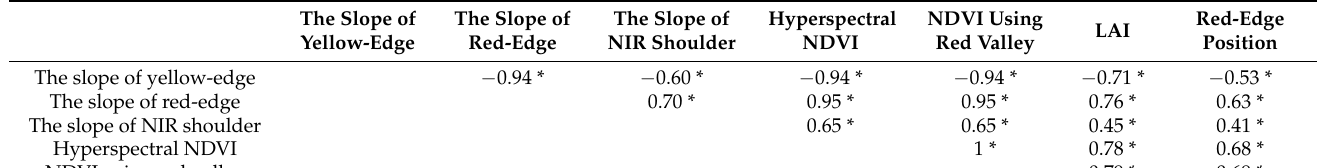
Table A1. Correlation matrix between LAI and different spectral metrics.